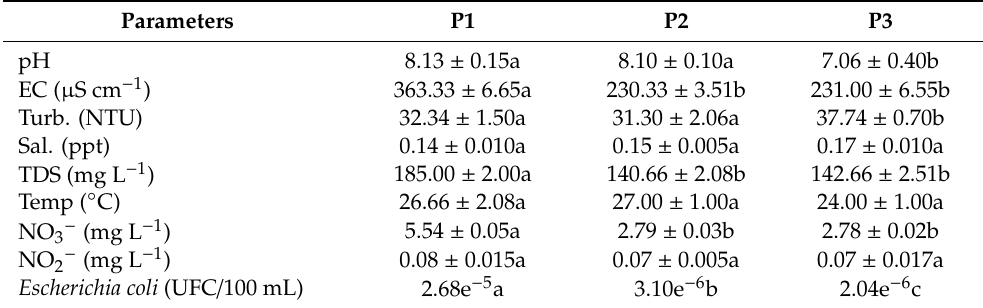
Table 1. Evaluation of the physicochemical and microbiological parameters in the three sampling points analyzed in the dry